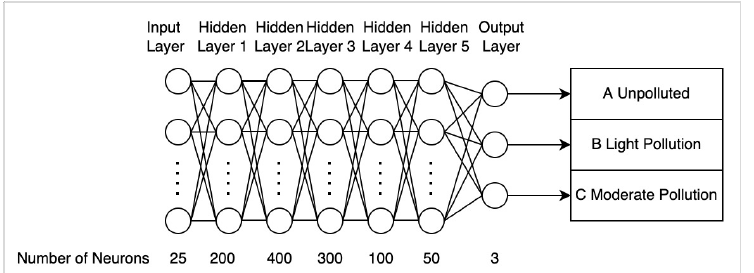
Figure 6. Architecture of DNN